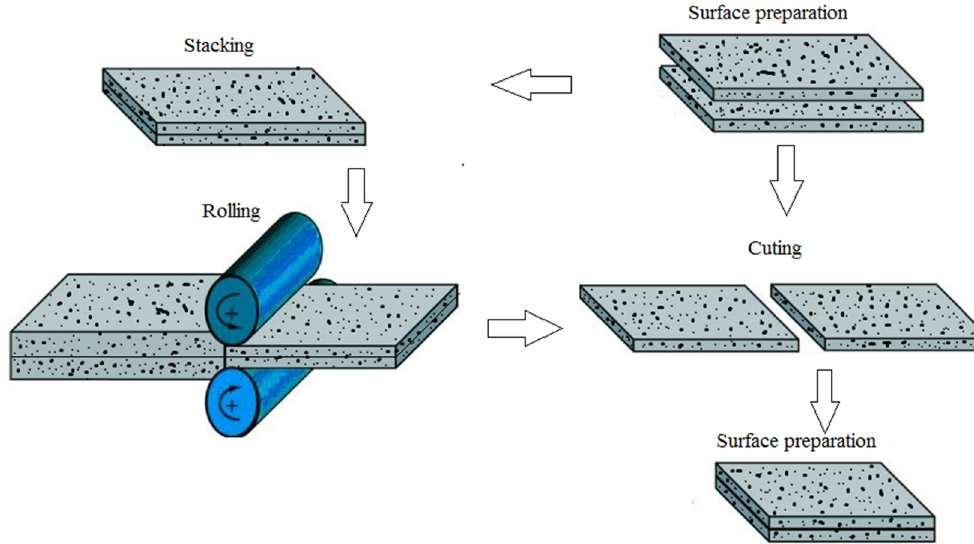
Figure 2: Graphic diagram of the ARB.